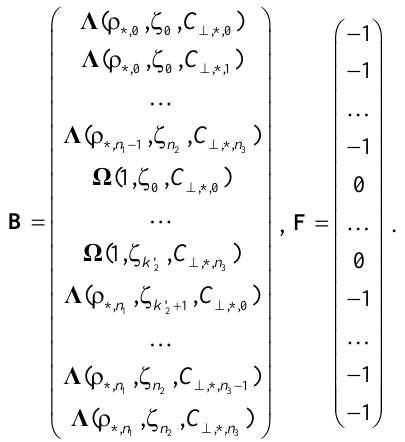
Table 1. Values of